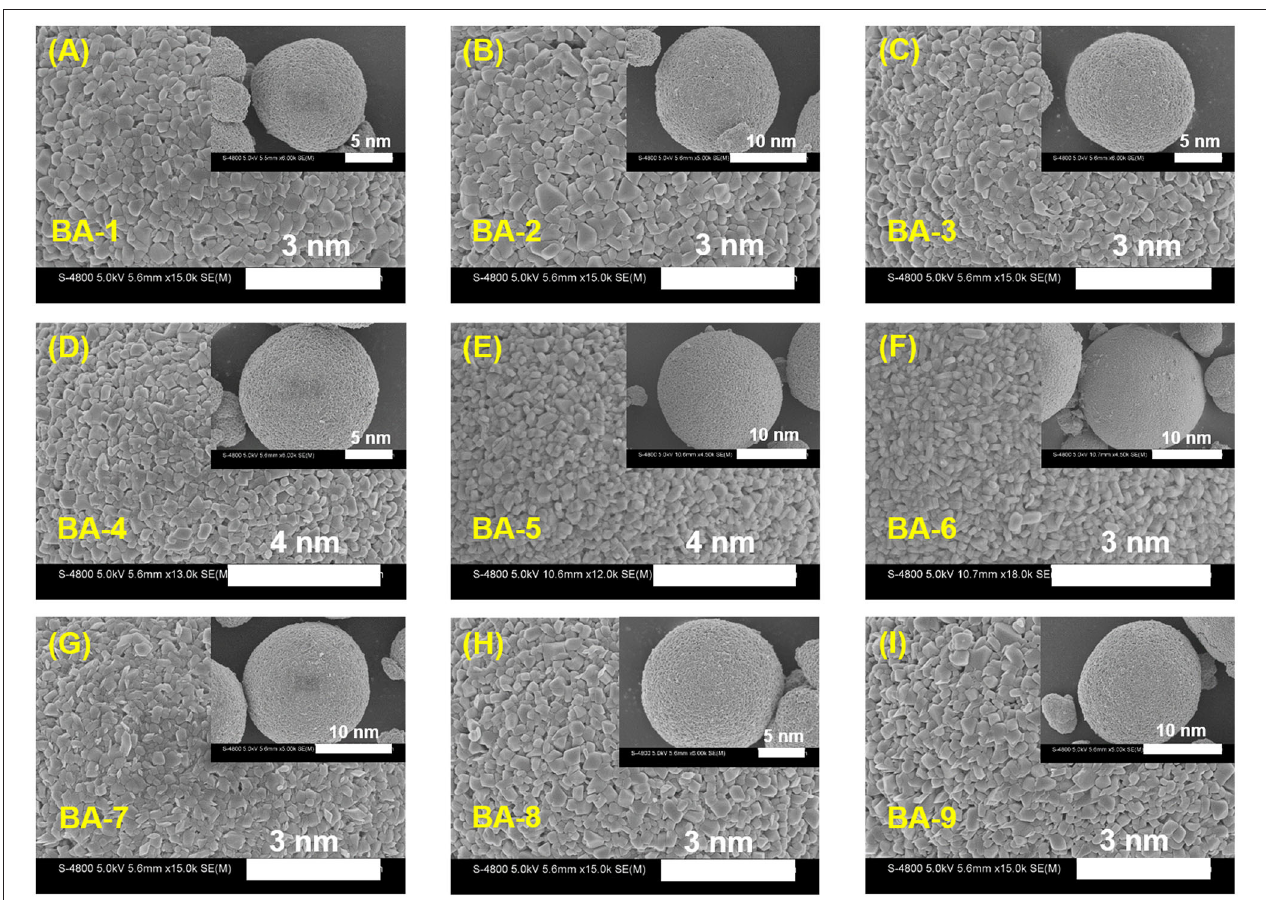
FIGURE 2 | The magnifying SEM images of (A–I) BA-1 to BA-9. The inserts are SEM images of their corresponding particles.